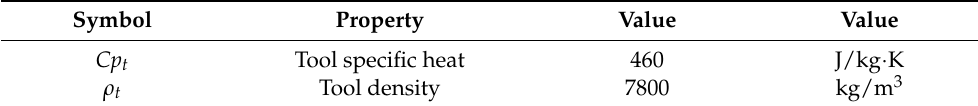
Table 2. Physical values of hot stamping tool steel for dies and punches at room temperature. Symbol Property